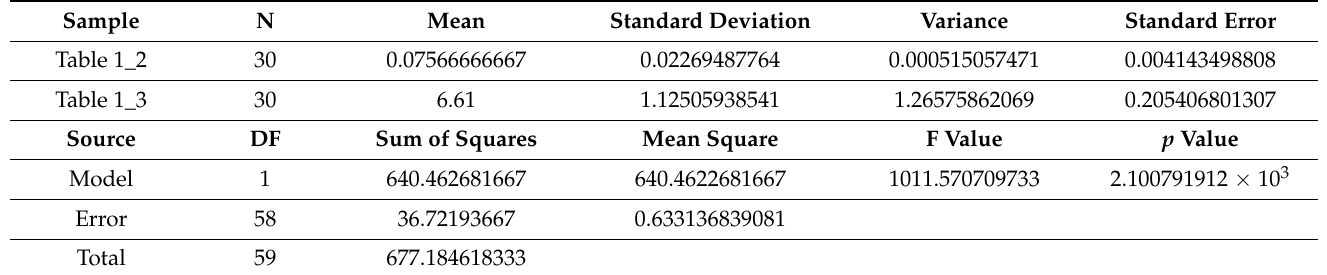
Table 3. One-way ANOVA analysis of the dependence of mass loss and flame spread on tree species.